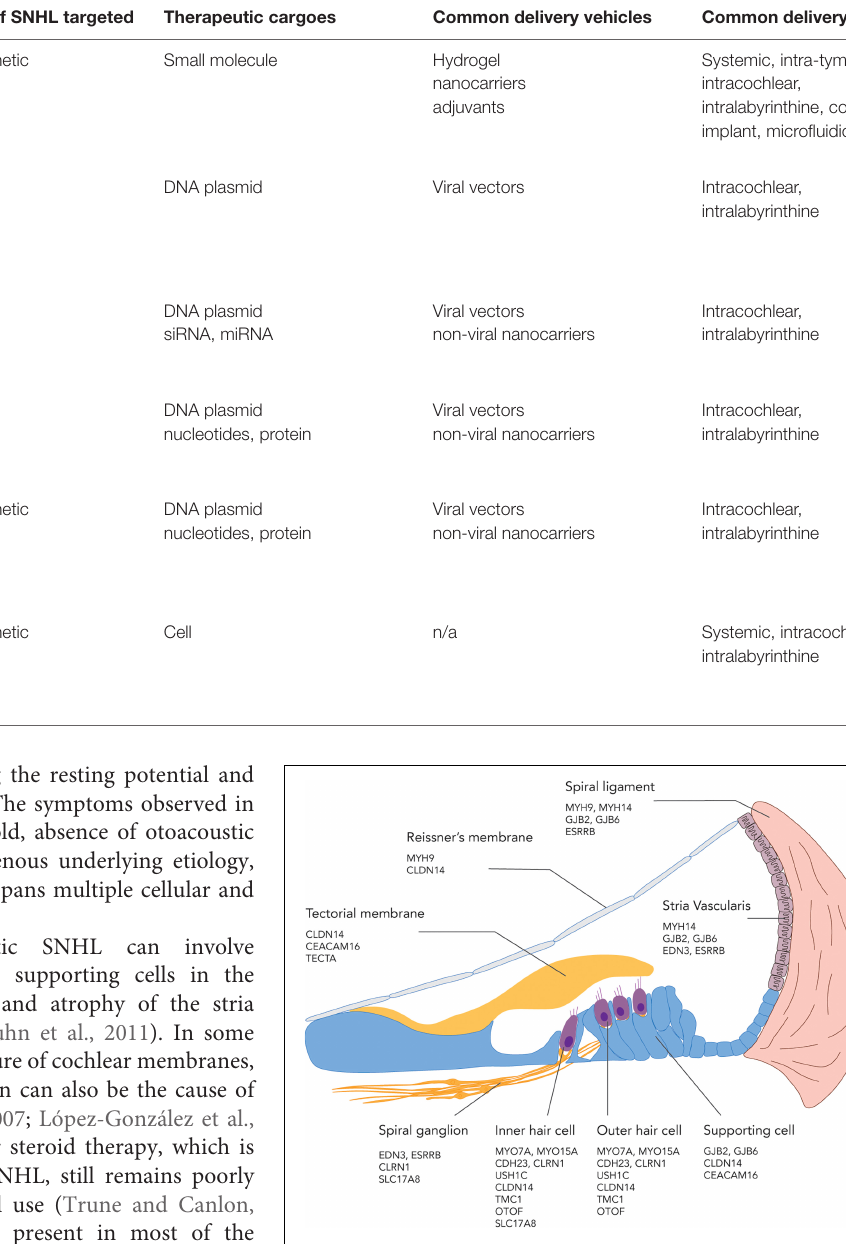
FIGURE 2 | An illustration showing possible sites of genetic defects in the cochlea and a subset of genes involved in SNHL at each